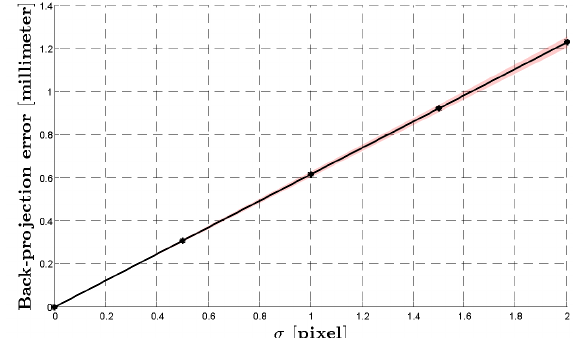
Figure 5: The reprojection error versus the random noised added to the image points. The reprojection error was computed using (18). The red shaded area shows the standard deviation of repro- jection error.